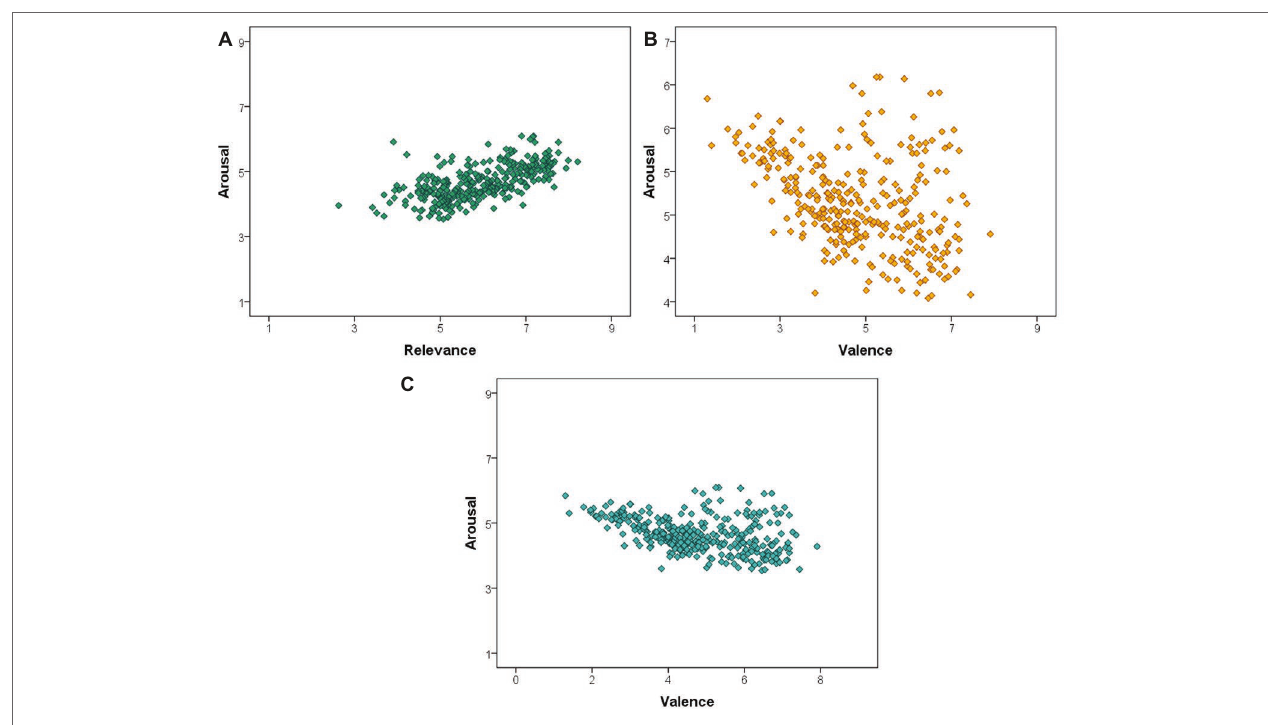
FIGURE 2 | (A) There was a strong, positive correlation between images rated high in relevance to climate change and images rated high in arousal. (B) There was a moderately strong, negative correlation between images that were rated high in relevance to climate change and images that were rated low in valence. (C) There was a moderate, negative correlation between images that were rated low in valence and images that were rated high in arousal.